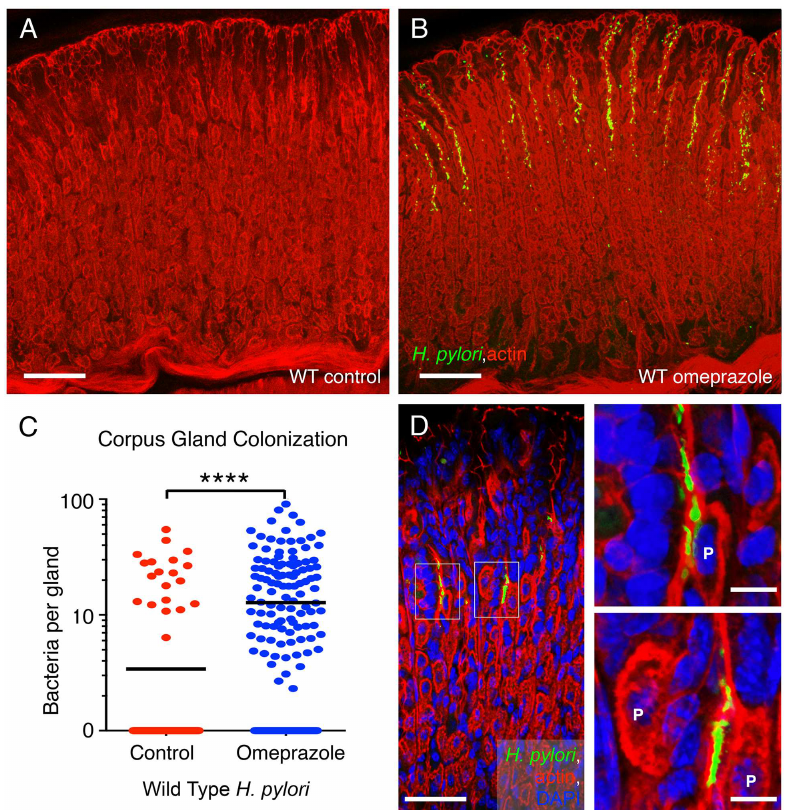
Fig 8. Omeprazole treatment expands H . pylori colonization into the corpus glands of stomach. ( A-B ) Representative confocal3D images of the corpus glandsinfected with wild-type(WT) H . pylori followedby 1-week treatment or no treatment with omeprazole. H . pylori are stainedin green and the cellularactin cytoskeleton is stainedwith phalloidinin red. Scale bar 100 μ mfor both panels. ( C ) Quantification of the numberof bacteria per gland in the corpus of animalsinfected with WT H . pylori treated with omeprazole or untreated control. The corpus glands of seven animalsin each cohort were analyzedfor bacterial colonization by 3D volumetricanalysis.Only one out of seven control animalshad detectablebacteria in the corpus. **** P < 0.0001 (Mann Whitney test). ( D ) Highermagnification image of the corpus glandsfrom omeprazole- treated animalsinfected with wild-type H . pylori . H . pylori are stainedin green and actin in red. Gland- associated H . pylori are seen in proximity to parietalcells (P) magnifiedin the insets. H . pylori are stained with antibodies in green. The glandsare visualized with actin staining with phalloidinin red and nuclei are stained with DAPI in blue. Scale bar is 100 μ min D and 10 μ min the insets in D.